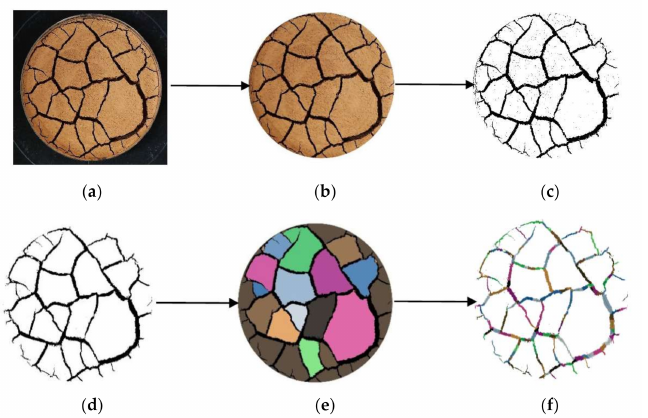
Figure 3. Crack image processing flow chart. ( a ) Background removal, ( b ) Radius equalization, ( c ) Thresholding, ( d ) Impurity removal, ( e ) Block recognition, ( f ) Crack